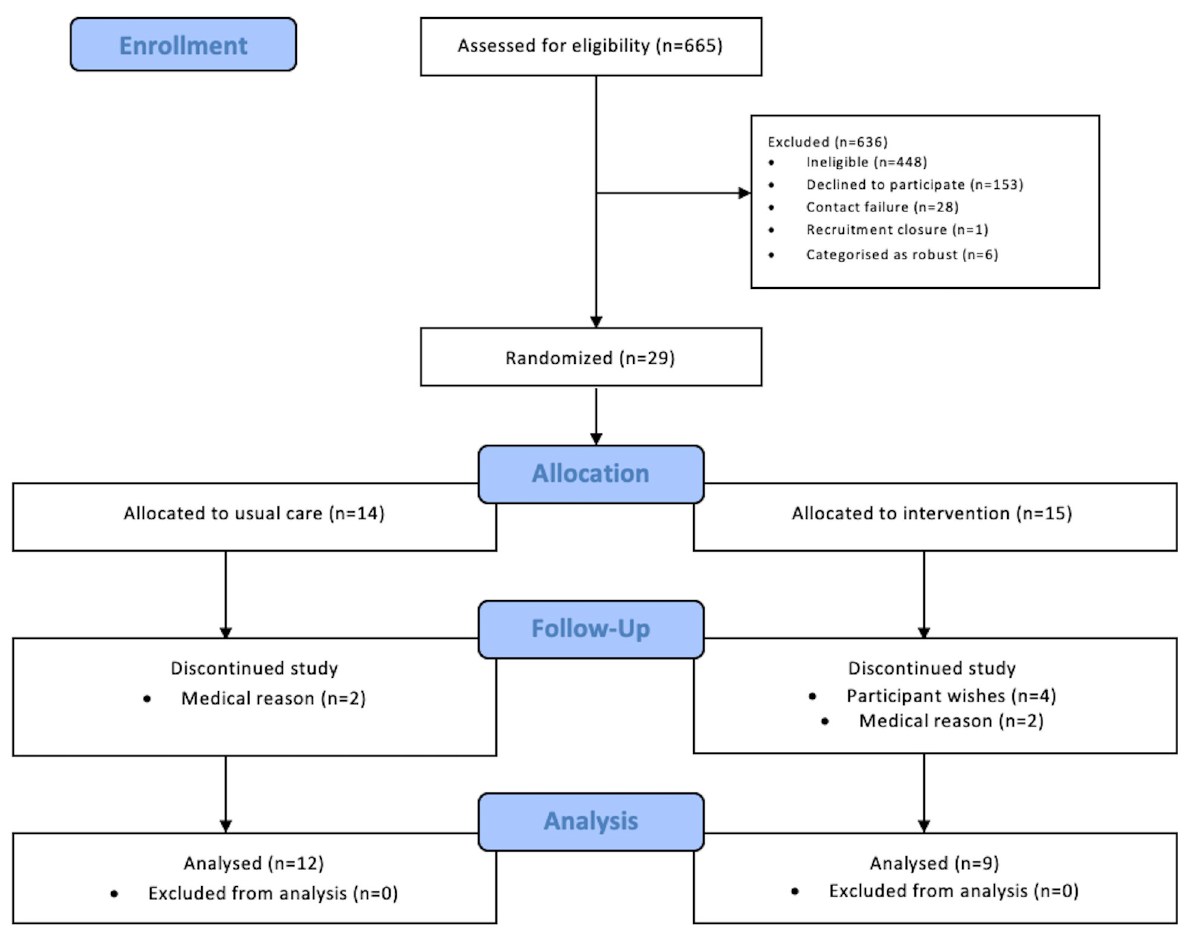
Fig 1. Study flow diagram.